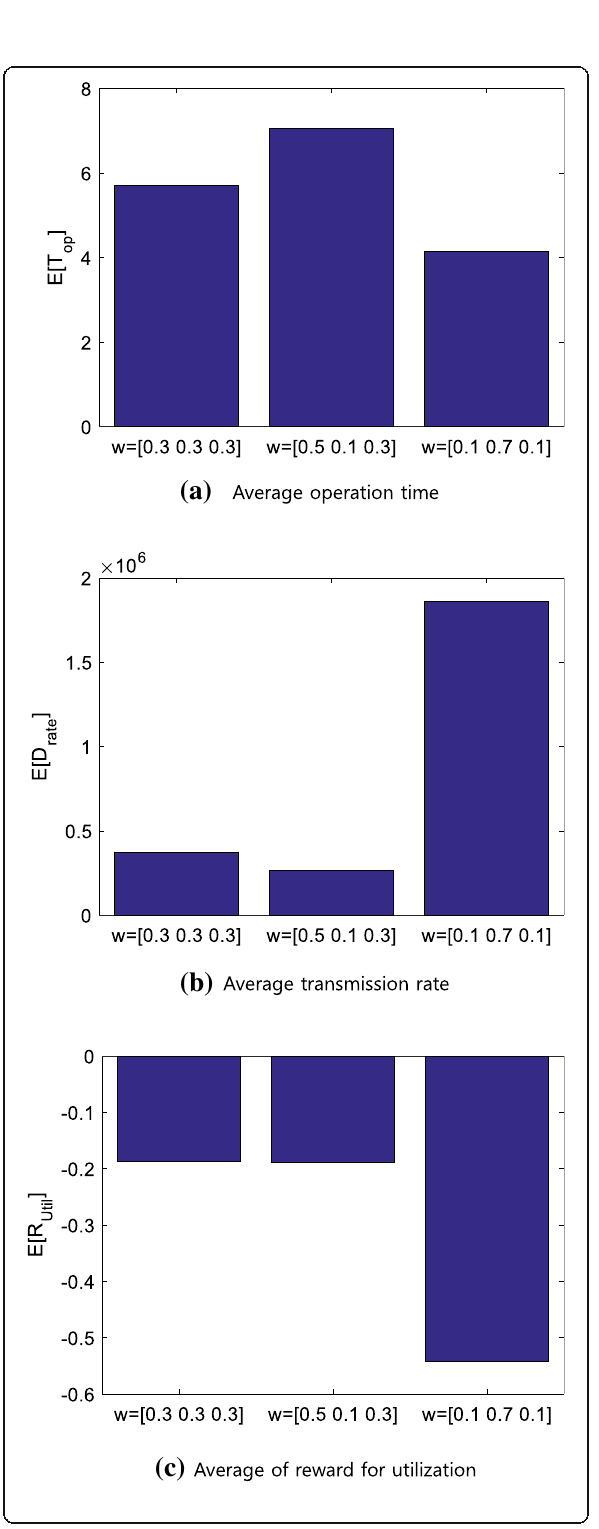
Fig. 17 a Average operation time, b average transmission rate, and c reward of utilization according to weight change. The average operation time, average data rate, and reward for channel utilization by changing the weight assignment for DDR to 40 kbps. Since the reward function is composed of the weighted sum of the objective functions, the Q-learning can be operated according to the desired objective function by adjusting the weight. Therefore, if the weight of the operation time is increased, the average operation time is increased, and if the weight of the data transmission rate is increased, the average transmission rate is increased. Finally, increasing the weight of reward for utilization increases the average of reward for